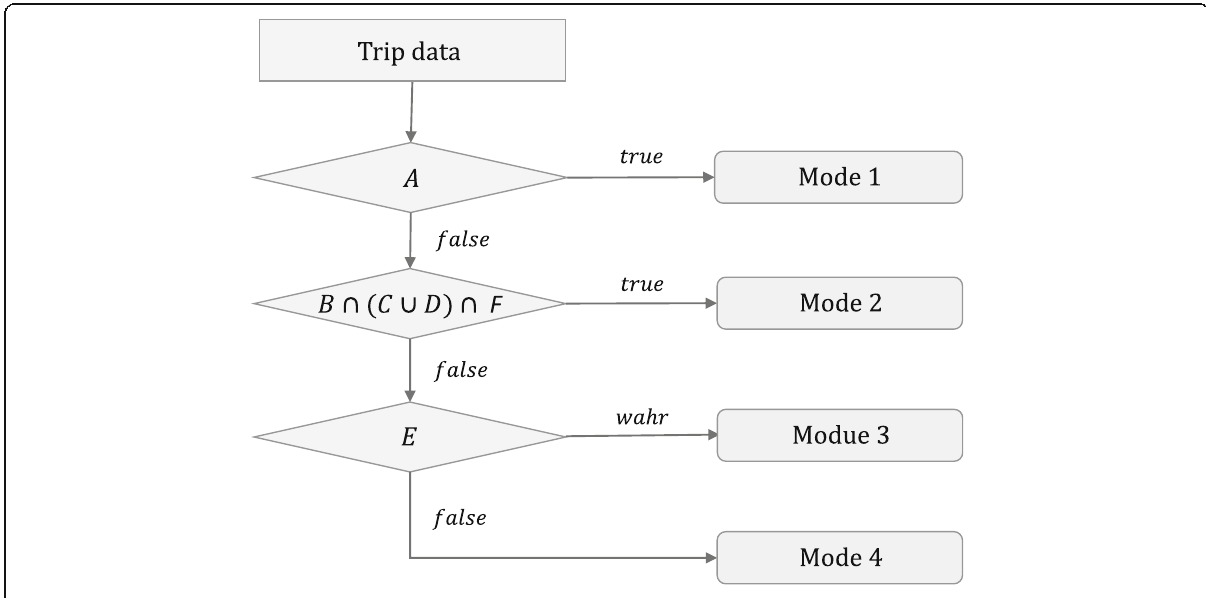
Fig. 6 Decision tree for mode